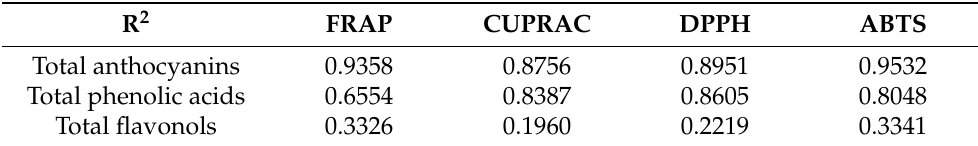
Table 4. Calculated correlation coefficients (R 2 ) which describe the dependence of antioxidant activities and the sum of concentrations of anthocyanins, phenolic acids and flavonols determined with HPLC